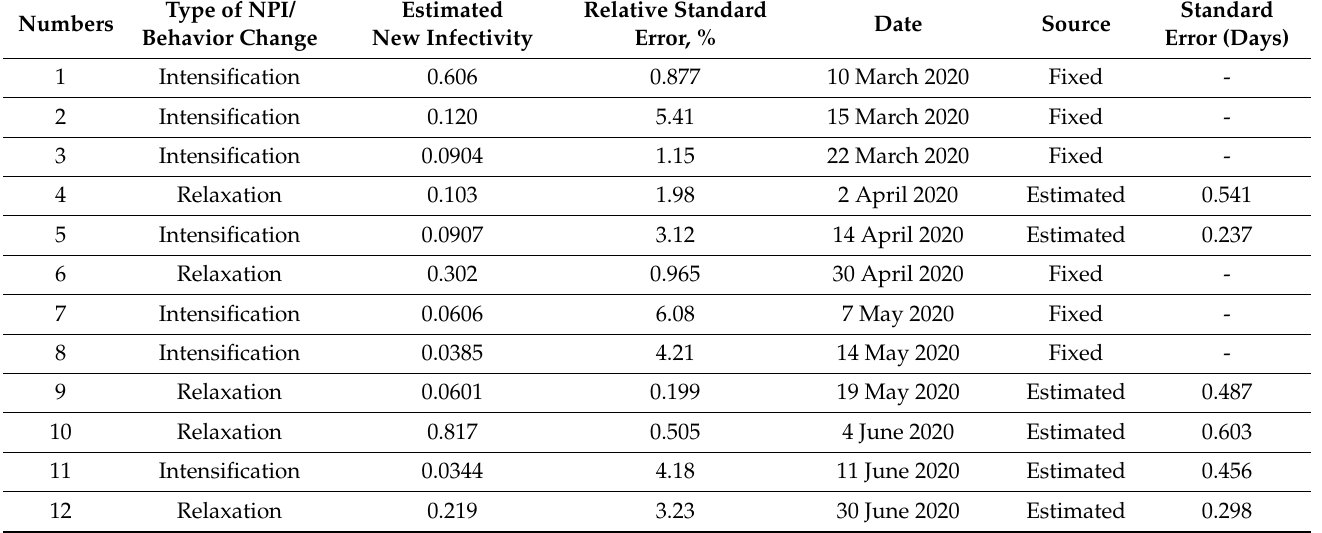
Table A6. Time points of changes in infectivity and respective values for Saxony. We used fixed (known due to Governmental decisions or random events) and estimated time points of changes of NPI/contact behavior and events and respective changes in infectivity of asymptomatic subjects. We provide estimates and relative standard errors of the infectivity starting with the date mentioned (3 to 5